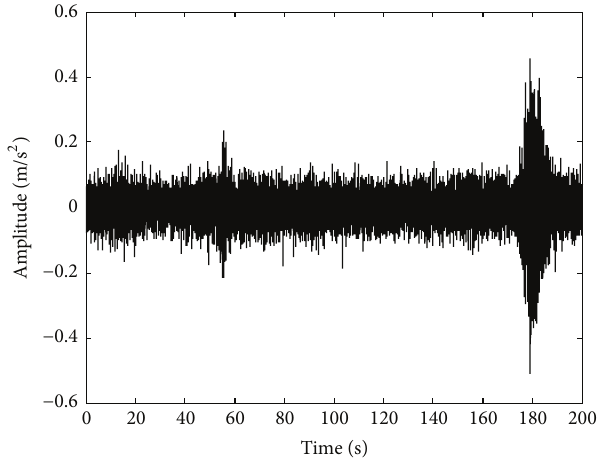
Figure 10: Measured acceleration